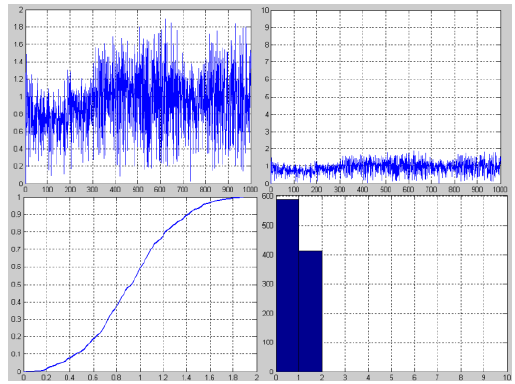
Figure9. horizontal direction of error statistics about the integrated positioning under UKF